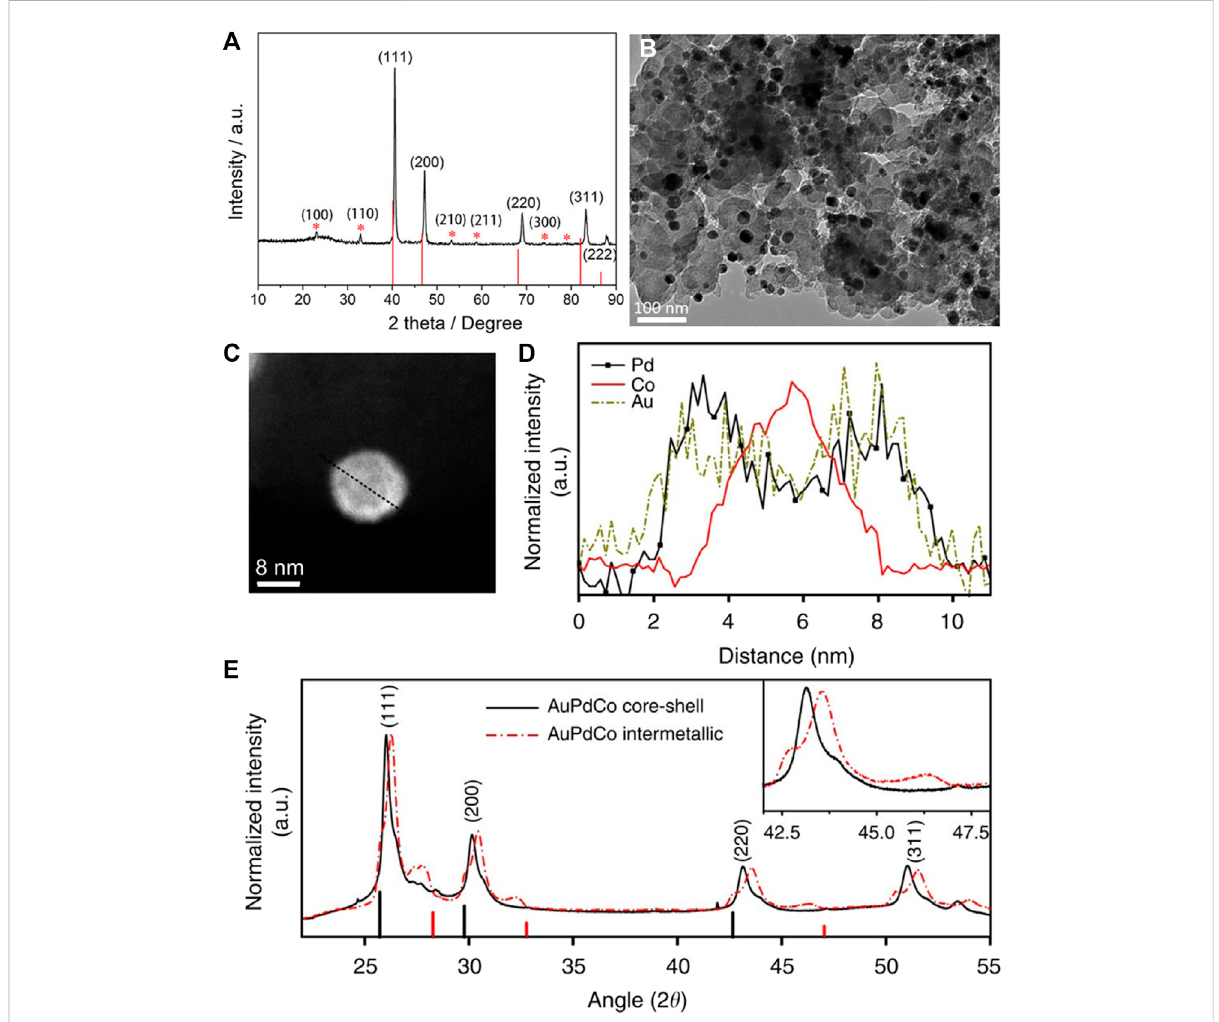
FIGURE 3 (A) XRD pattern of the ordered Pd 3 Fe/C; drop lines correspond to Pd (JCPDS No. 46-1,043). (B) TEM image of the ordered Pd 3 Fe/C. (Liu et al., 2018) Copyright 2018 Nano Research. (C,D) High angle annular dark- fi eld-STEM image of a core-shell AuPdCo nanoparticle with its corresponding EELS line-scan pro fi les. Scale bar, 5 nm. (E) XRD patterns for core-shell and intermetallic AuPdCo nanoparticles. The black and red vertical lines indicatethe(111),(200),and(220)peakpositionsofpurePdandCore fl